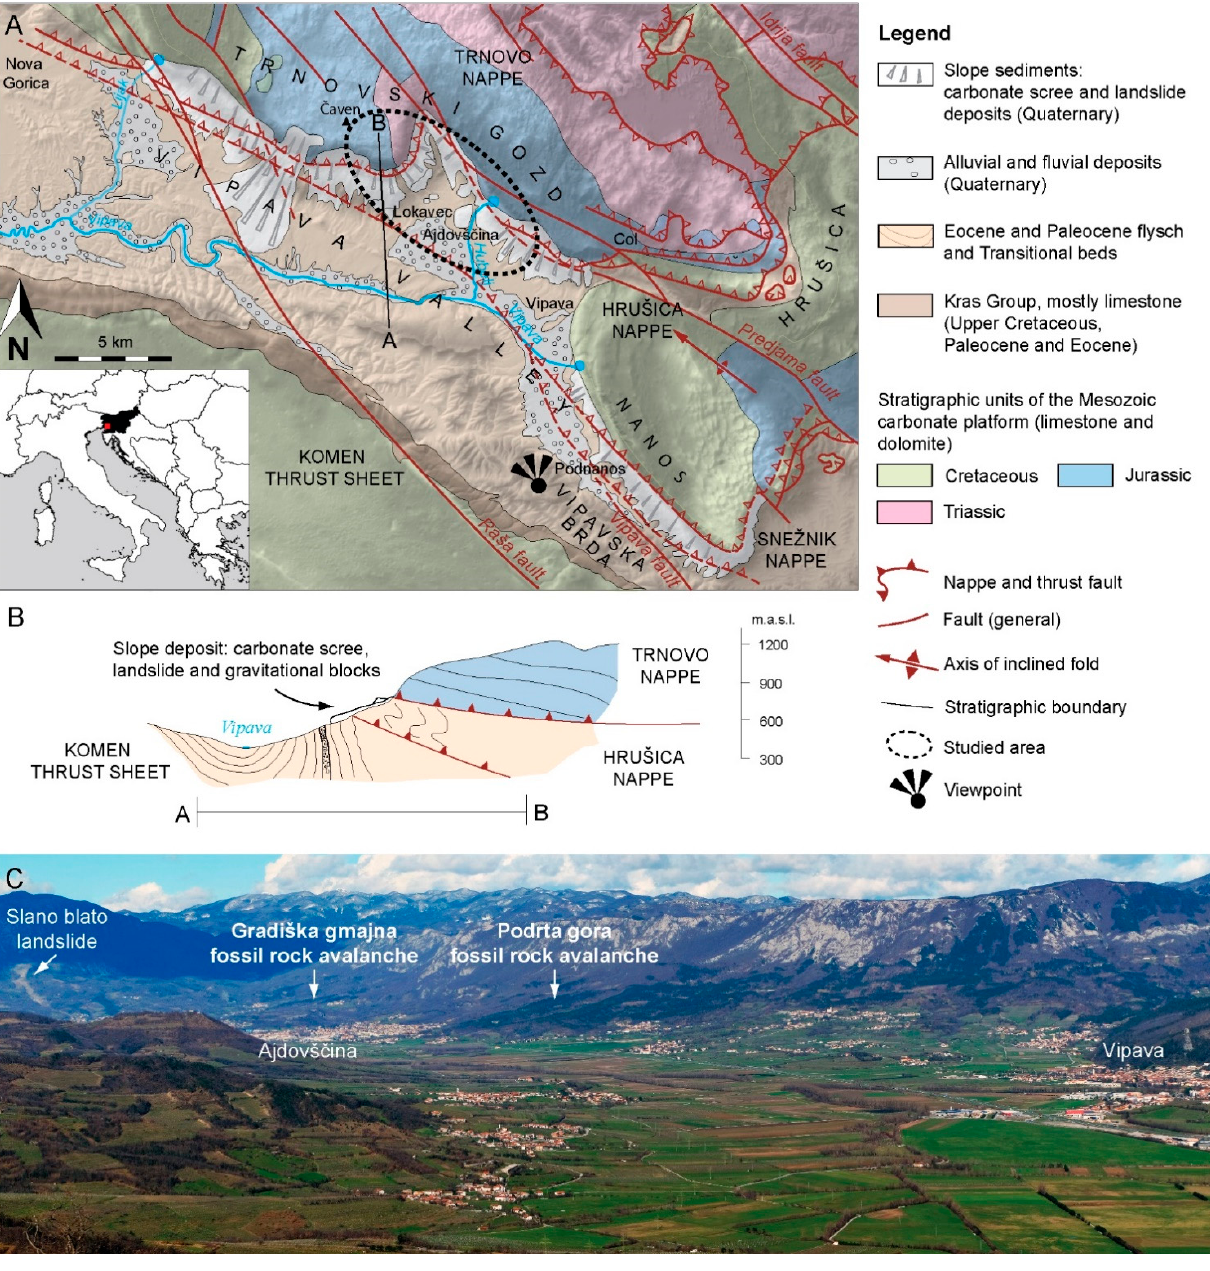
Figure 1. ( A ) Geological map of the extended area of the Vipava Valley; ( B ) cross-section through the Trnovski gozd and Vipava Valley; ( C ) panoramic view from Sveti Socerb to the Vipava Valley and Trnovski gozd in the hinterland (geological map modified after [1,3,11,14,24–27].